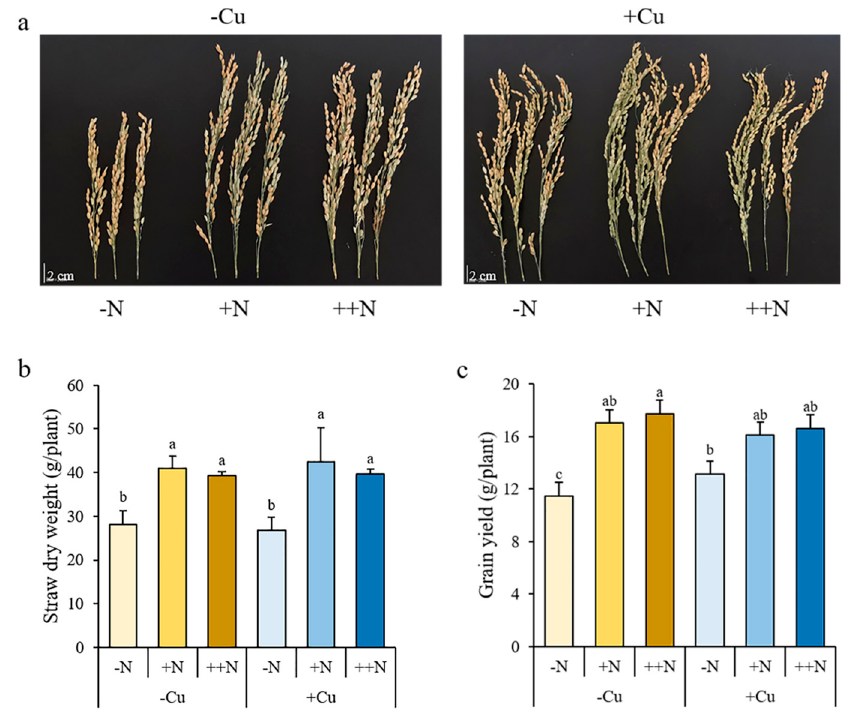
Figure 7. The panicles ( a ), straw dry weight ( b ), and grain yield ( c ) of rice plant grown in soil with different combinations of Cu (-Cu, 0 mg Cu kg − 1 soil; +Cu, 50 mg Cu kg − 1 soil) and N (-N, 0 g N kg − 1 soil; +N, 0.2 g N kg -1 soil; ++N, 0.4 g N kg -1 soil) supply at mature stage. Data are means ±SD of three biological replicates. Different letters indicate significant difference at p < 0.05 by Tukey’s test.